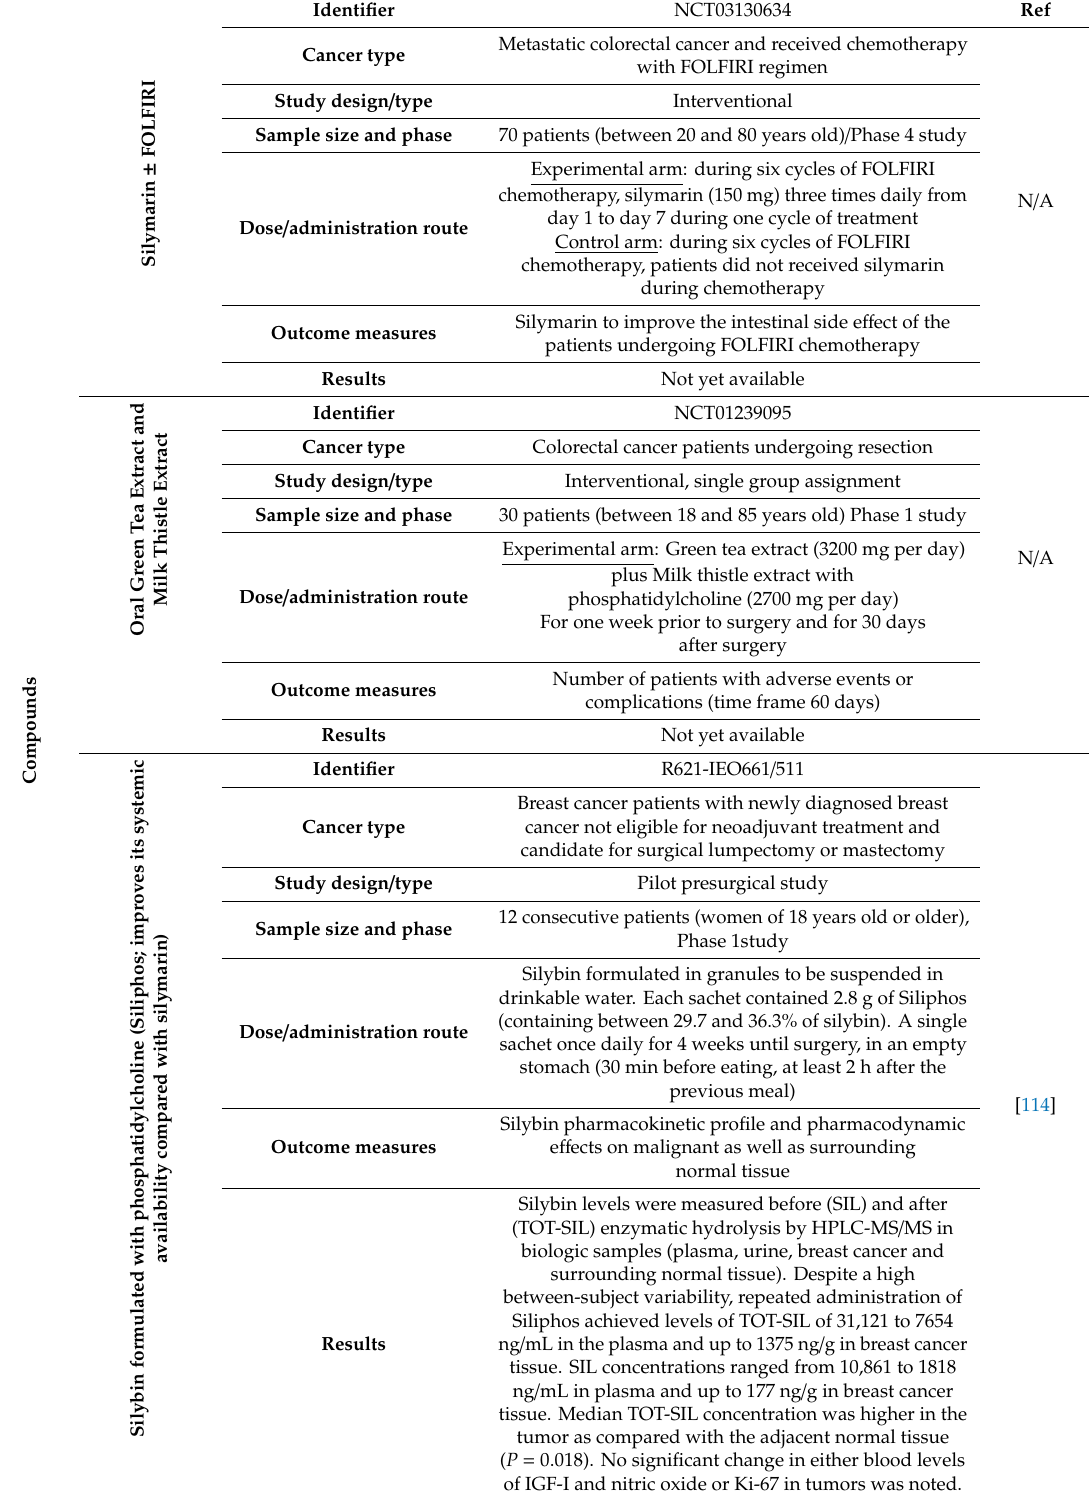
Table 3. Clinical studies of Silymarin and derivatives in a cancer